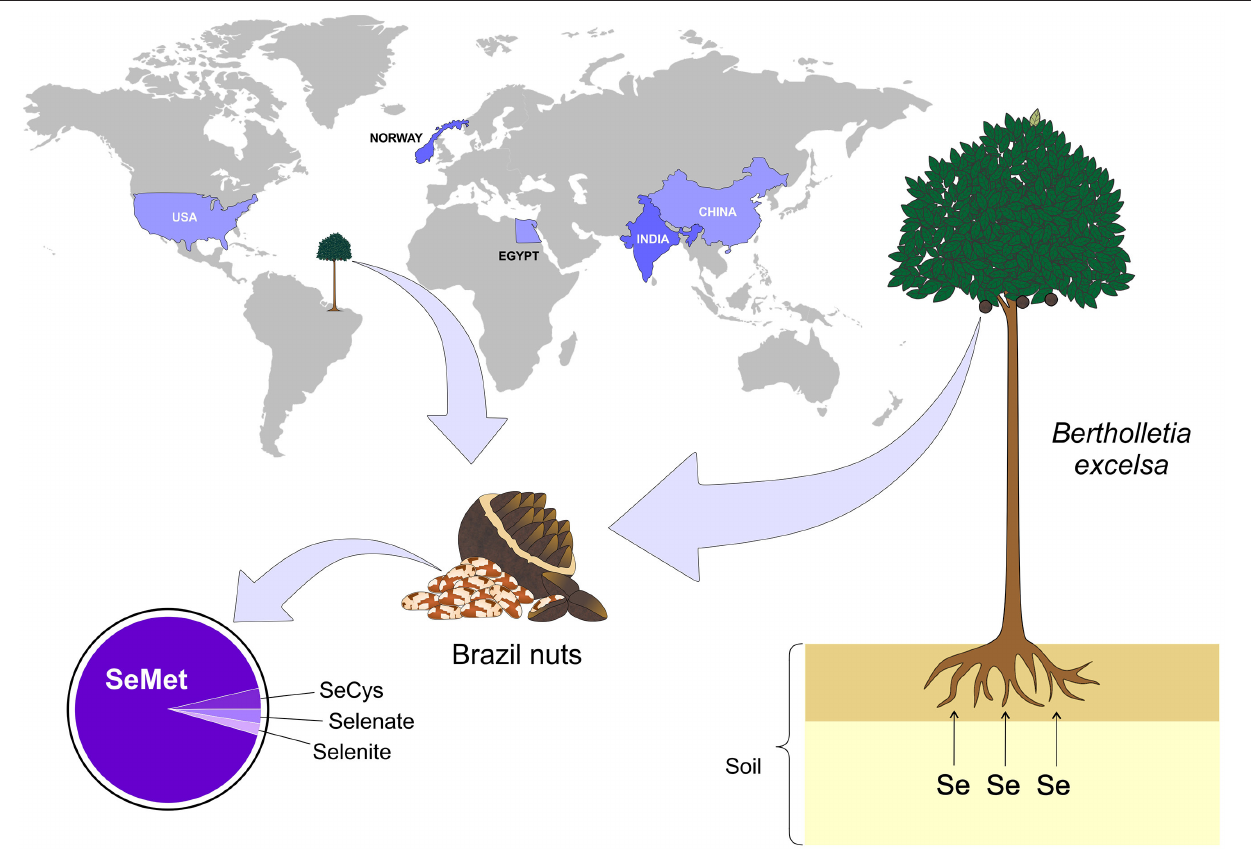
FIGURE 2 | Main countries with documented Se-rich soils. The presence of Se-rich soil is not uniform in the world, but some countries such as Egypt, China, India, Norway, and USA stand out among the others. On the other hand, some plants are more capable of retaining Se, for example - Bertholletia excelsa (Brazil nuts), which is a typical tree of the northern region of Brazil. Se, selenium; SeMet, selenomethionine; SeCys, selenocysteine (Figure illustration by Francisco Irochima Pinheiro).